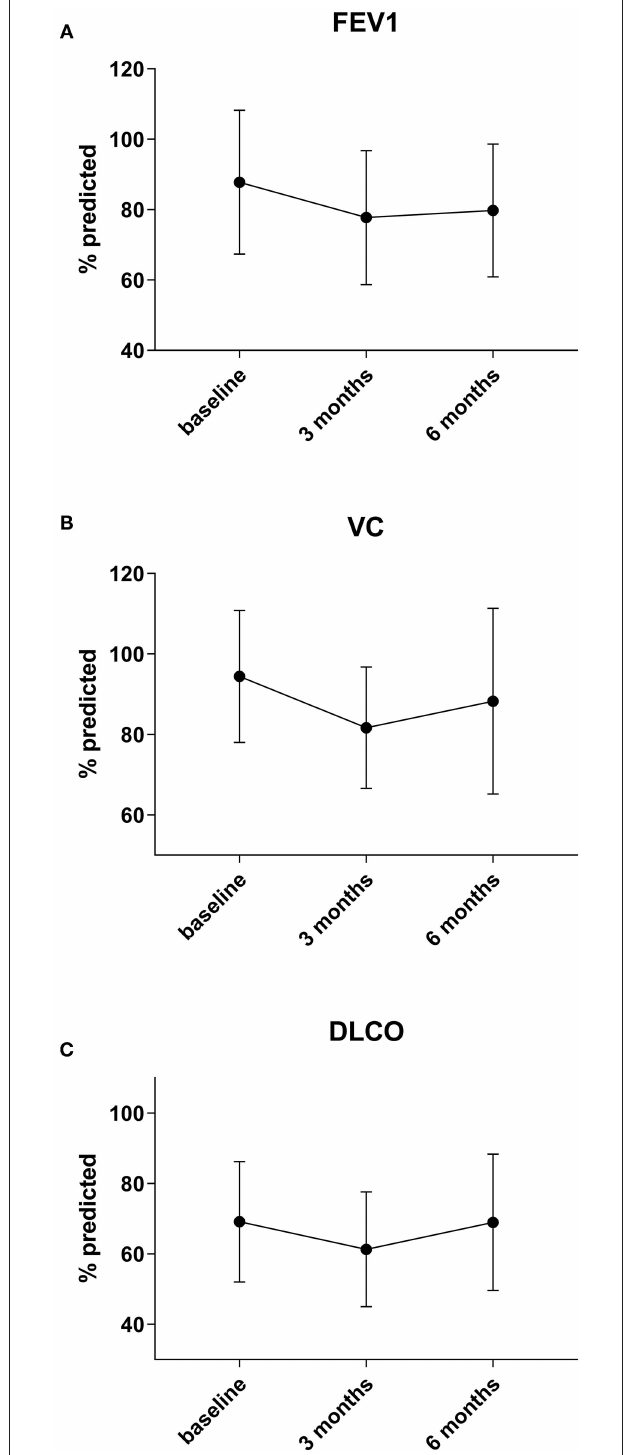
FIGURE 2 | In the subgroup of patients in whom only 1 or 2 metastases were resected a significant recovery of DLCO (C) between 3 and 6 months by 4 % can be observed ( p = 0.003). VC (B) also improves by a median of 3%, but not statistically significant, while FEV1 (A) shows no relevant recovery ( + 1, 4%) in this group ( p = 0.26 and p =